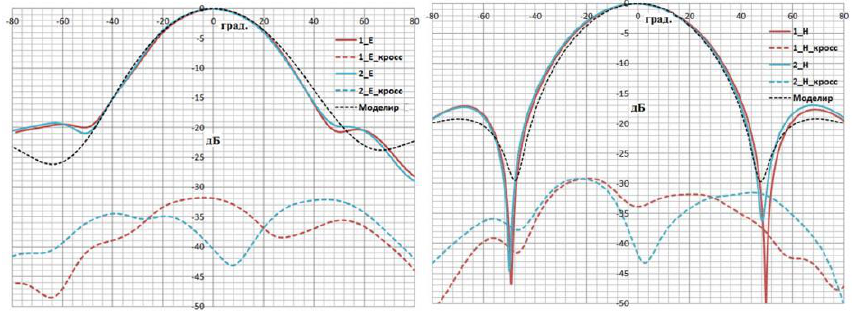
Fig. 2. The antenna patterns for E and H planes. The band pass filter and amplifaer amplitude friquence diagrams are represented on Fig. 3.